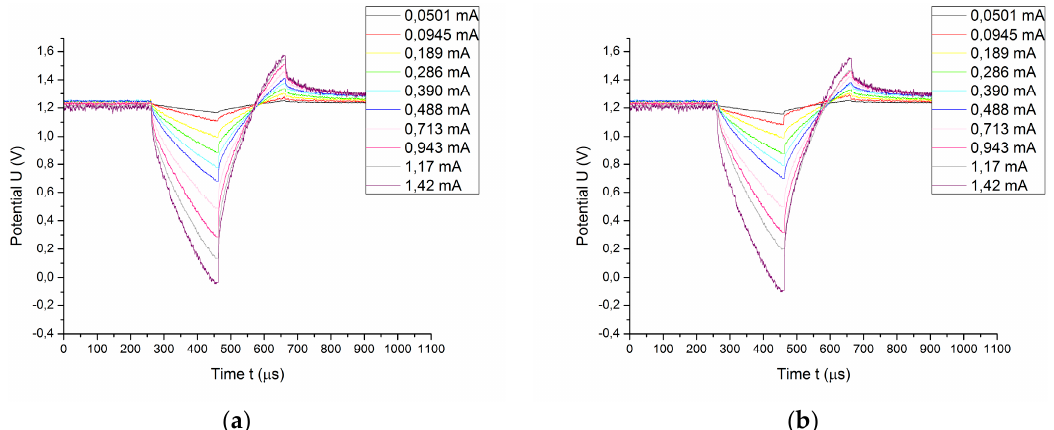
Figure 12. Potential transients of electrode B after the access voltage is subtracted. ( a ) Access voltage calculated by using conventional method (method 1). ( b ) Access voltage calculated by using proposed method (method 2).